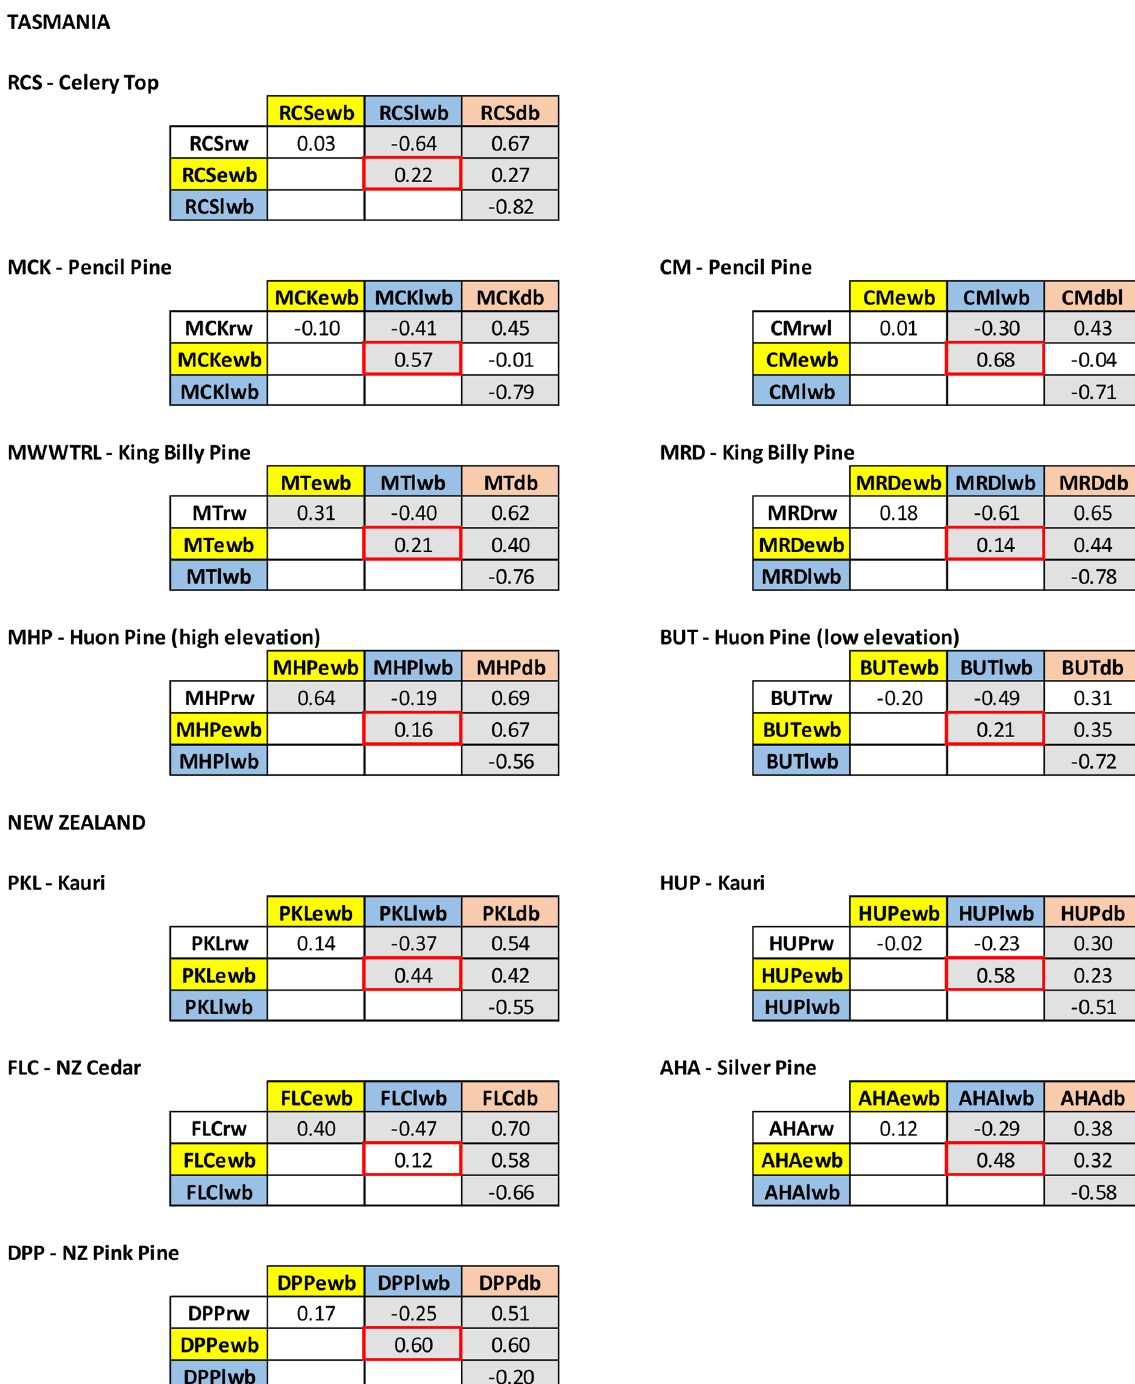
Table A2. Correlation matrices for each site between the four detrended TR parameter chronologies (1798–1995). Grey shading denotes a significant correlation